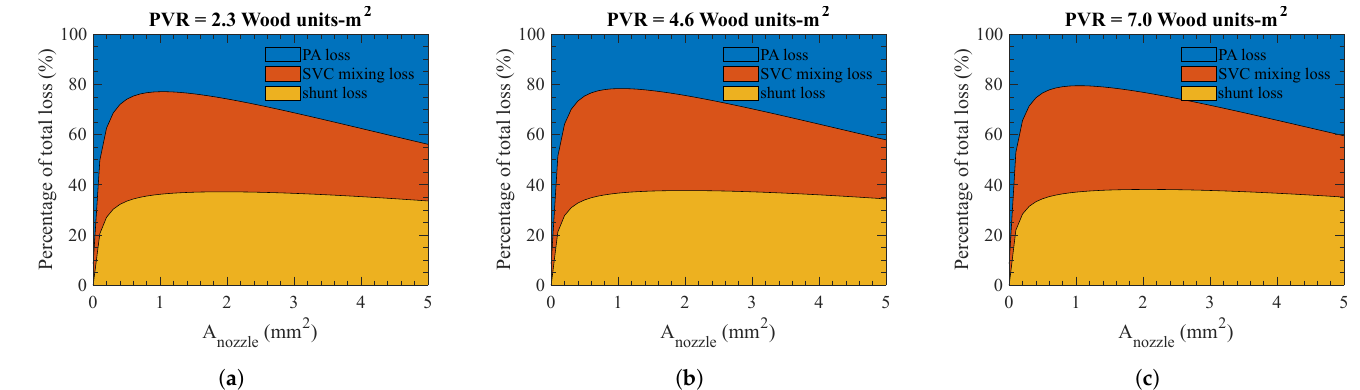
Figure 12. The same results as Figure 11, namely, losses in the ABG circulation, but on a relative scale at ( a ) normal PVR, ( b ) elevated PVR, and ( c ) high